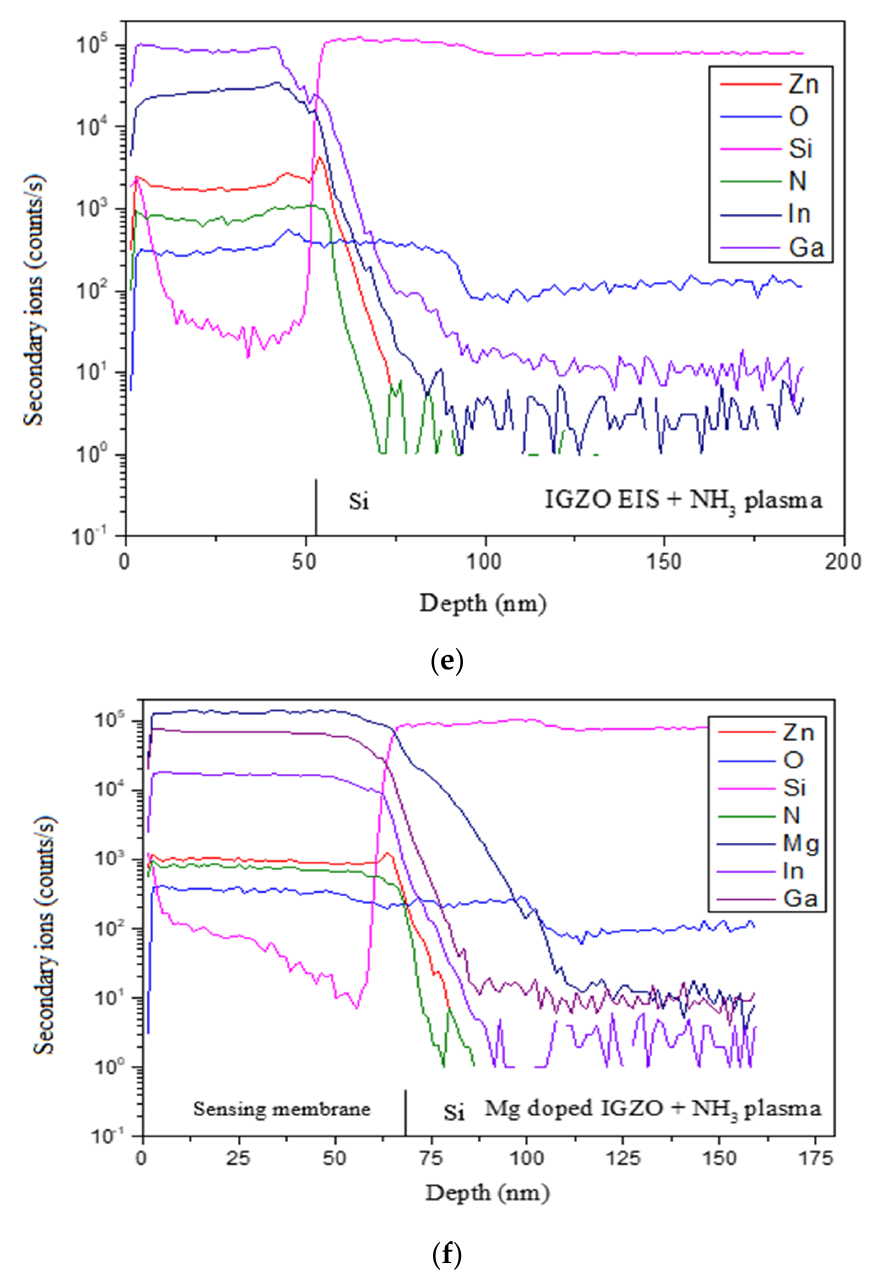
Figure 5. XRD patterns for ( a ) IGZO with NH 3 plasma treatment and ( b ) Mg doped IGZO with NH 3 plasma treatment. N 1s XPS spectra for ( c ) IGZO with NH 3 plasma treatment (only noise for the as-deposited sample: not shown) and ( d ) Mg doped IGZO with NH 3 plasma treatment. (Various plasma treatment times are included in ( a – c ), (only noise for the as-deposited sample: not shown) and ( d ). SIMS data for ( e ) IGZO with NH 3 plasma treatment for 3 min and ( f ) Mg doped IGZO with NH 3 plasma treatment for 3 min.